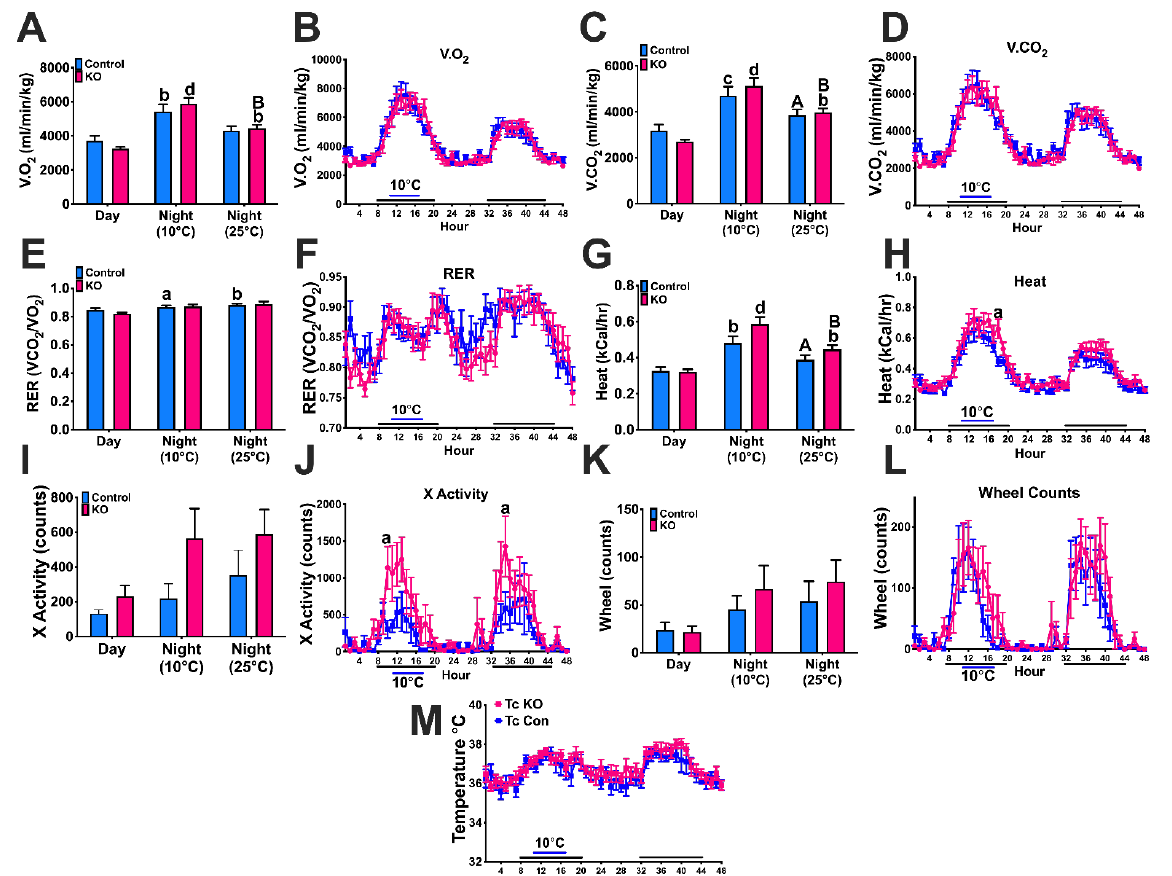
Figure 8. Response to cold stress in intact and chow fed control and Kiss1-GHSR KO (KO) female Daytime vs. nighttime volume of carbon dioxide production (V.CO2, ml/min/kg) and ( D ) Hourly volume of carbon dioxide production (V.CO2, ml/min/kg). ( E ) Daytime vs. nighttime respiratory exchange ratio (RER, V.CO2/V.O2), and ( F ) Hourly respiratory exchange ratio (RER, V.CO2/V.O2). ( G ) Daytime vs. nighttime energy expenditure (Heat, kCal/hr), and ( H ) Hourly energy expenditure